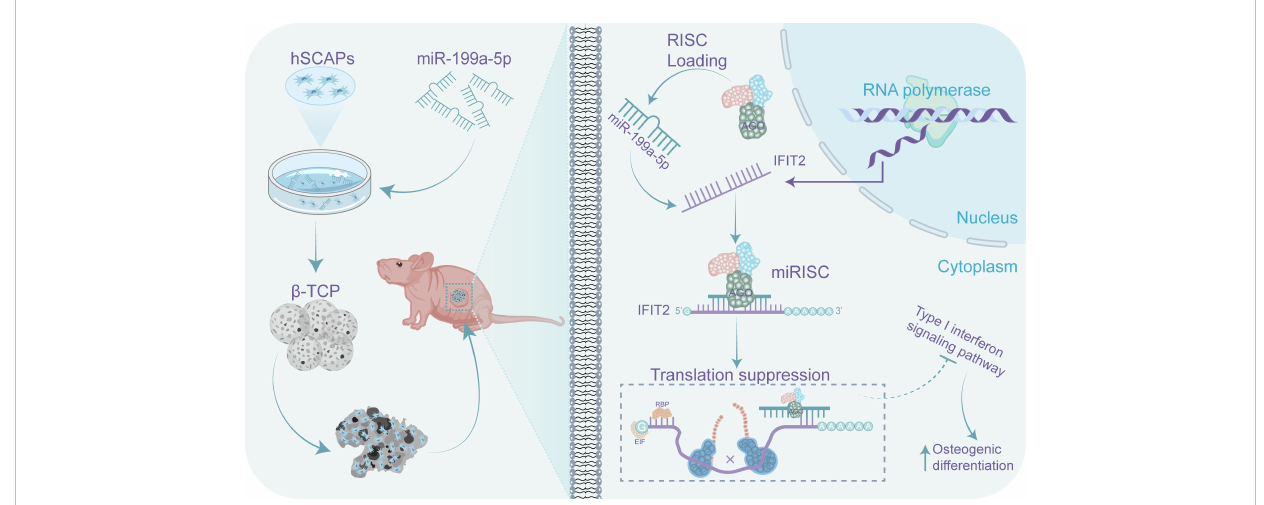
FIGURE 7 A schematic representation on how miR-199a-5p regulates the osteogenic differentiation of hSCAPs. miR-199a-5p promotes the osteogenic differentiation of hSCAPs via directly suppressing IFIT2 expression in vitro and in vivo , leading to blocking the type-1 interferon